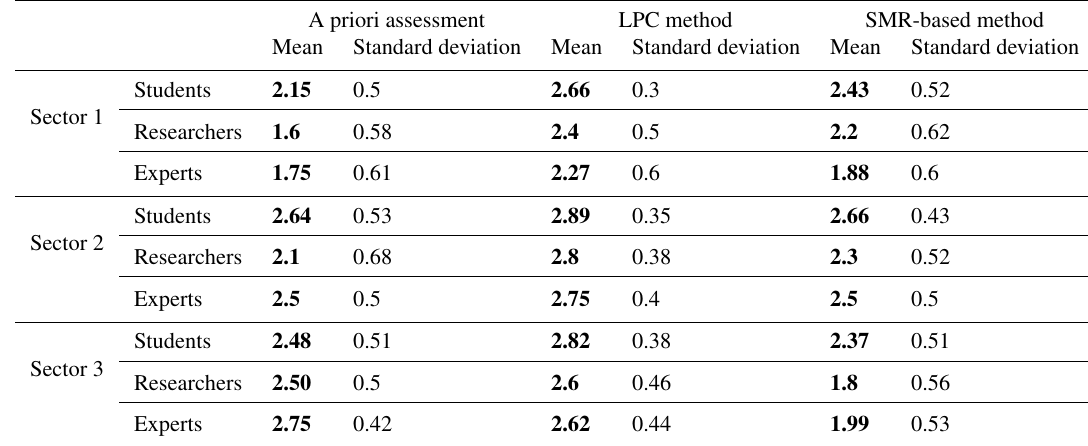
Table 8. Mean and standard deviation of the rockfall hazard levels for the three sectors.